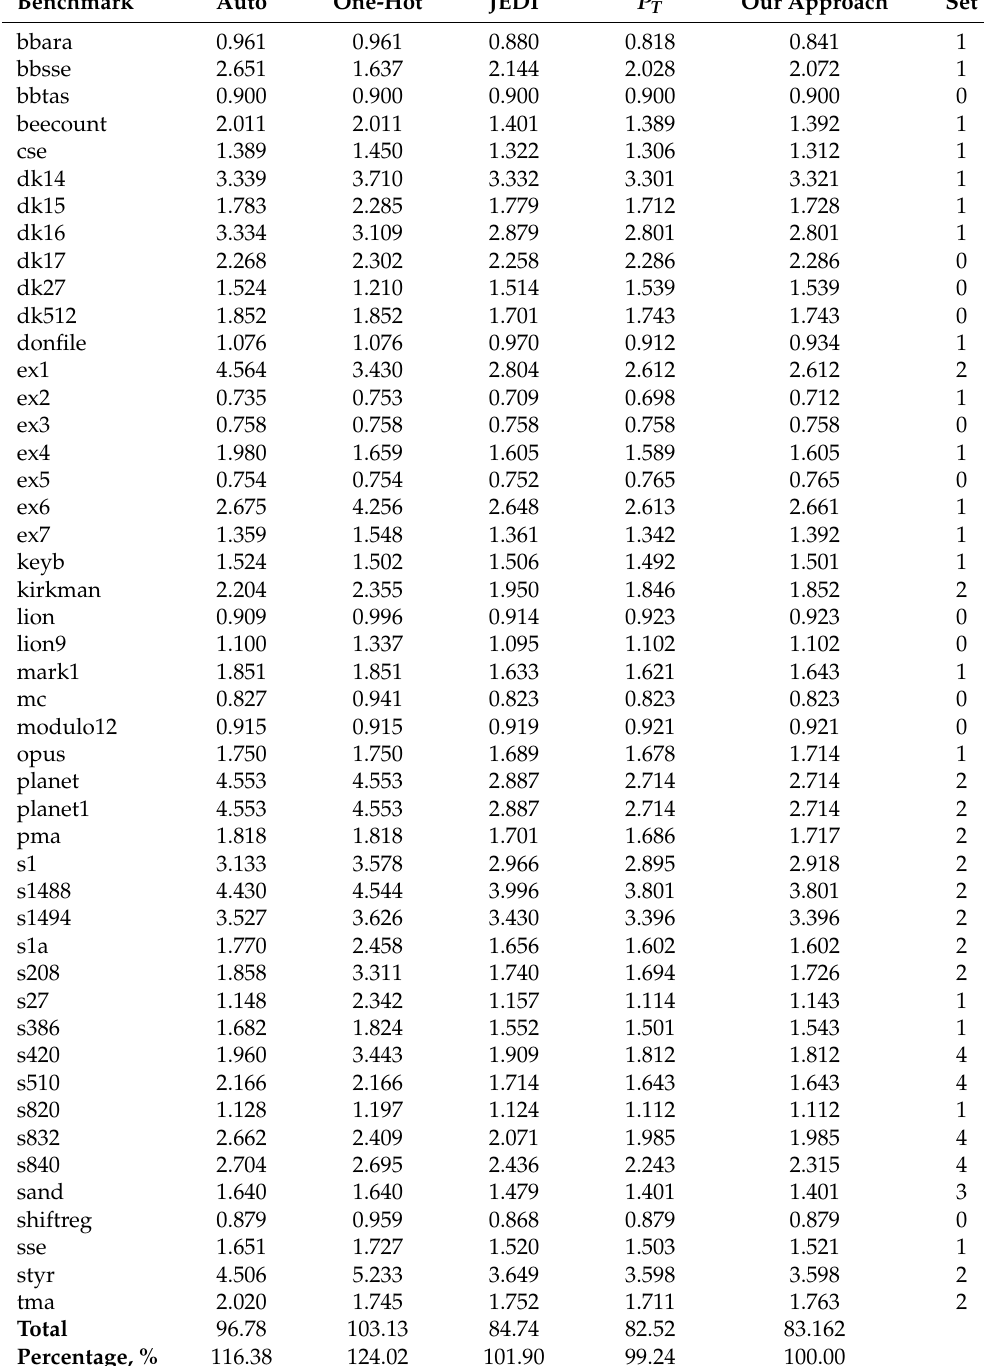
Table 12. Experimental results (the consumed power,